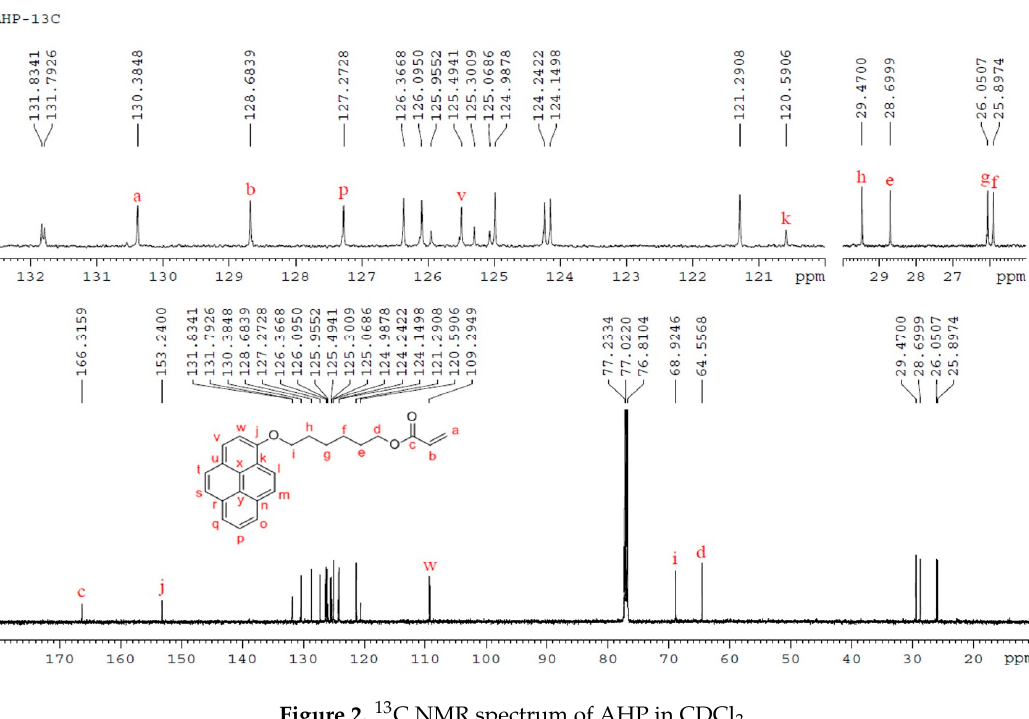
Figure 2. 13 C NMR spectrum of AHP in CDCl 3 .